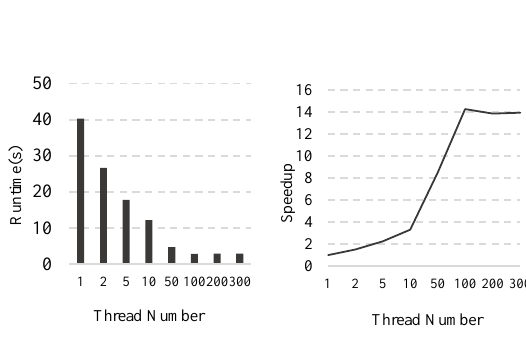
Figure10. Runtime and speedup for different number of threads in similarity and Laplacian matrix construction.